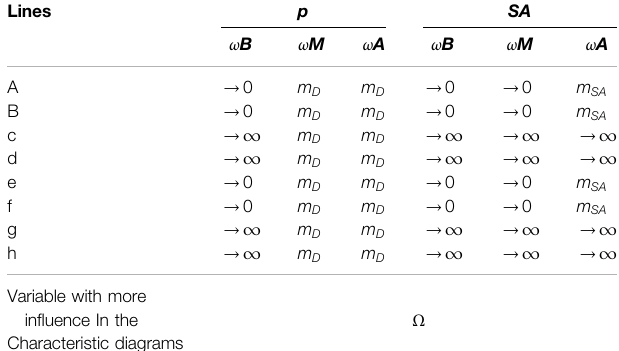
TABLE 8 | FA line diagram for the p and SA